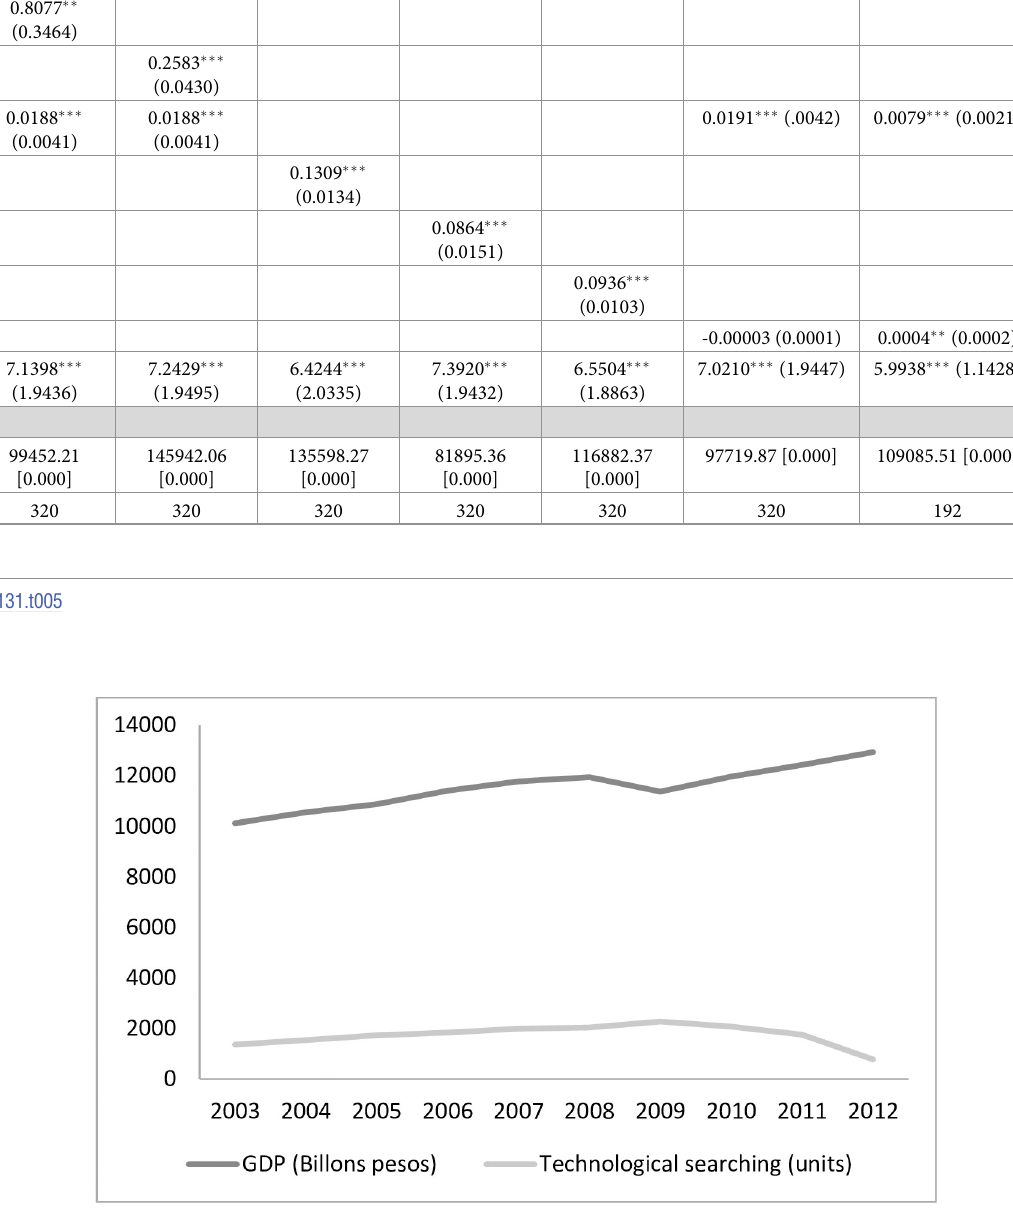
Fig 1. GDP and technological searches in Mexico. Source: Authors’ elaboration based on data from the National Institute of Statistics and Geography, Mexican Intellectual Property Institute.